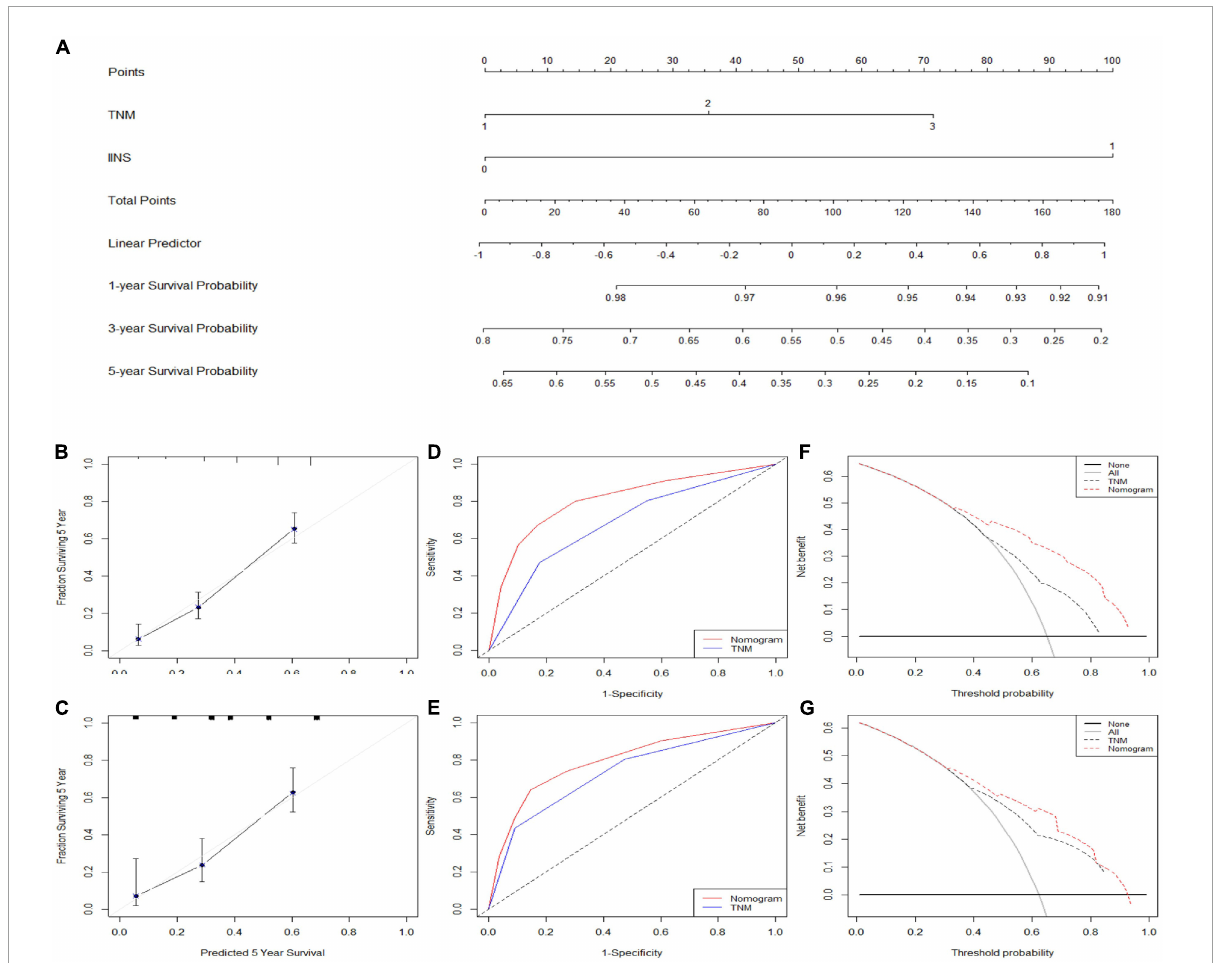
FIGURE8 Nomogram established and validated. Nomogram established based on integrative inflammatory and nutritional score (IINS) and tumor node metastasis (TNM) (A) . Calibration curves for 5-years cancer-specific survival (CSS) prediction in the training cohort (B) and validation cohort (C) . Receiver operating characteristic (ROC) analyses of CSS prediction in the training cohort (D) and validation cohort (E) . Decision curve analyses (DCA) revealed nomogram model in the training cohort (F) and validation cohort (G) . TNM 1/2/3, stage I/II/III; IINS 0/1, ≤ 2.35/ >